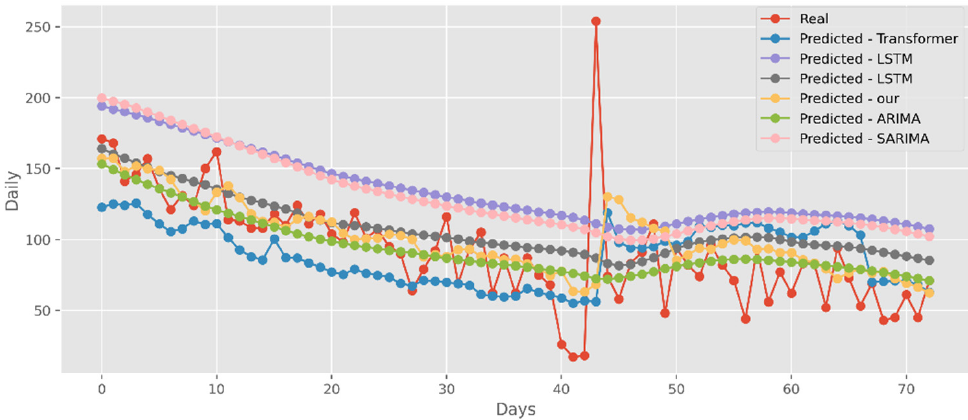
Figure 16. Comparison of COVID ‐ 19 prediction models of deaths in NY.